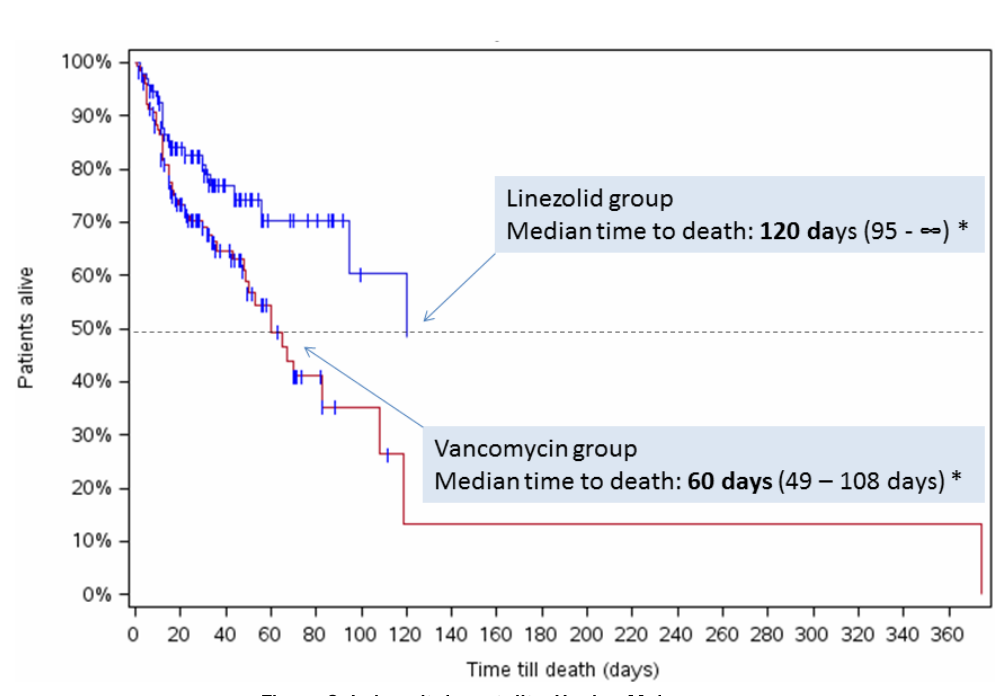
Figure 2: In-hospital mortality: Kaplan-Meier